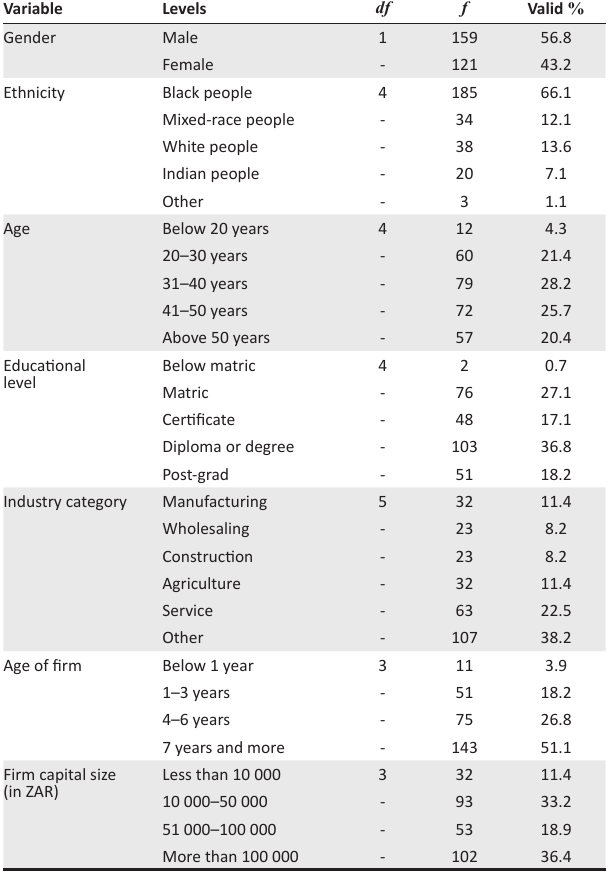
TABLE 2: Descriptive statistics for biographical variables ( N = 280).